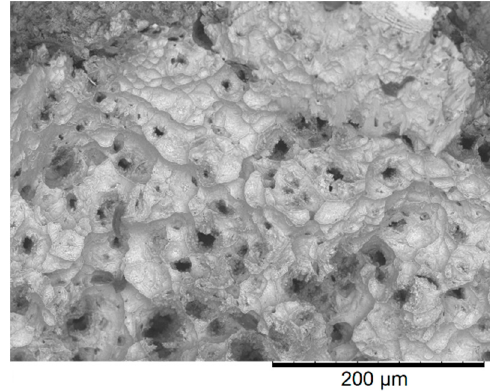
Figure 13. SEM micrograph of the fracture surface of the Widmanstätten plasma-nitrided Ti-6Al-4V alloy after creep test at 600 °C and 125 MPa.